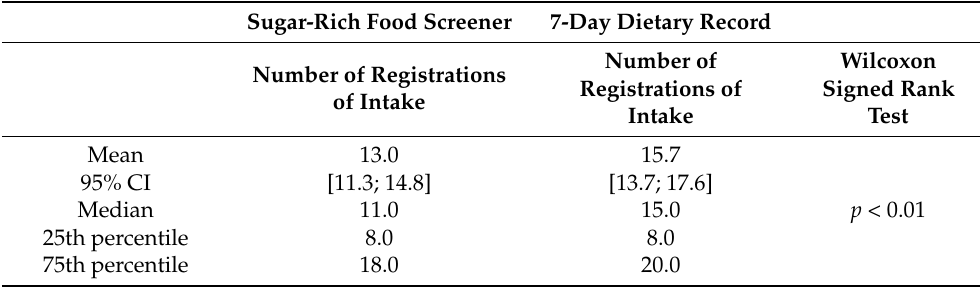
Table 6. Frequency of registrations of intake of discretionary foods and drinks in the SRFS and the 7-day dietary record ( n =